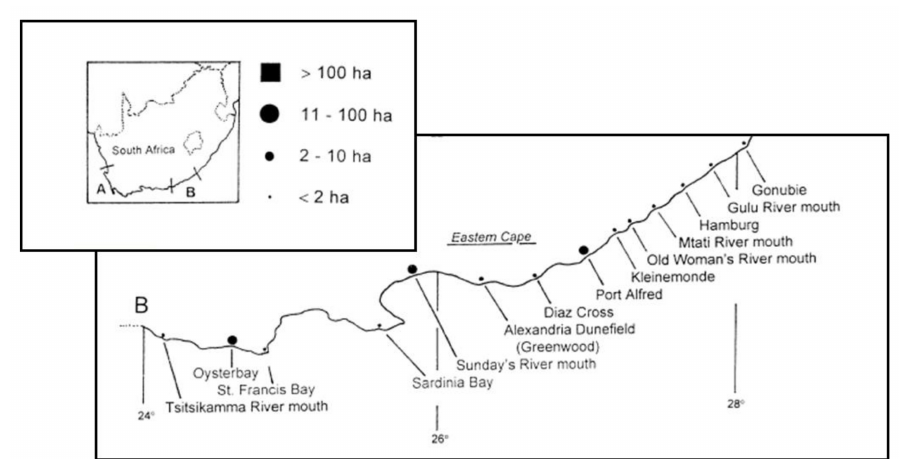
Figure 1. Distribution of Ammophila arenaria (marram grass) in the Eastern Cape, area B. Size of the dots shown in the map below indicates the area planted in hectares, see scale above. There was no area of >100 ha in this region (modified from Hertling [1]). Table 1. Planting of marram grass ( Ammophila arenaria ) in the Eastern Cape. (See Figure 1 for location of the sites) (Information from Hertling [1], where